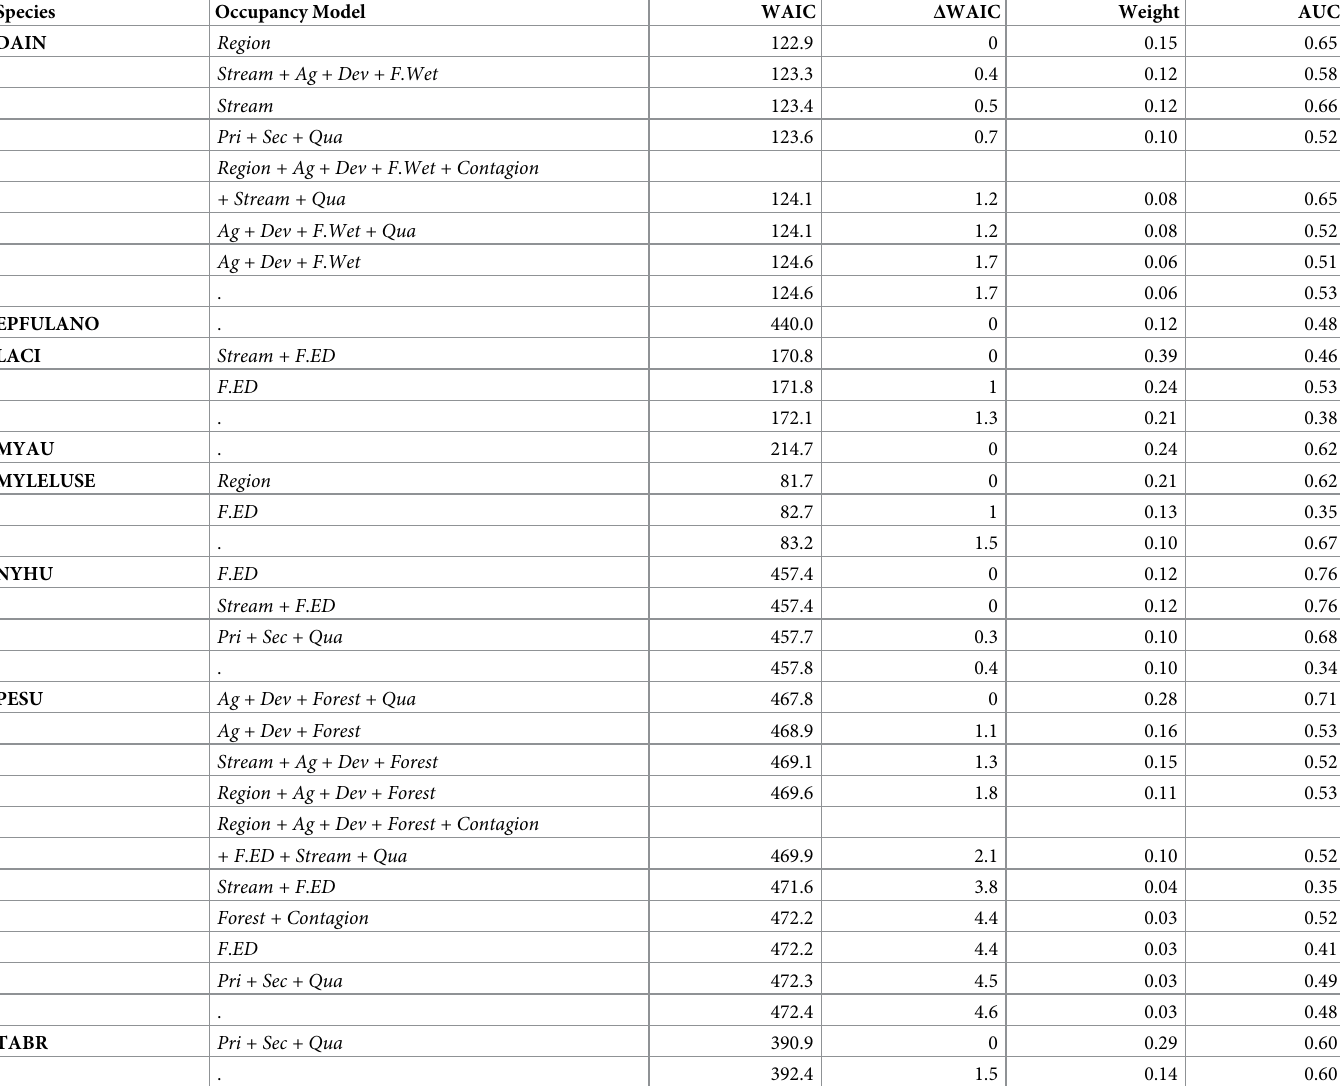
Table 3. Occupancy probability model results for each species of bat surveyed using acoustic detectors across South Carolina, May-July 2015 and 2016. Species